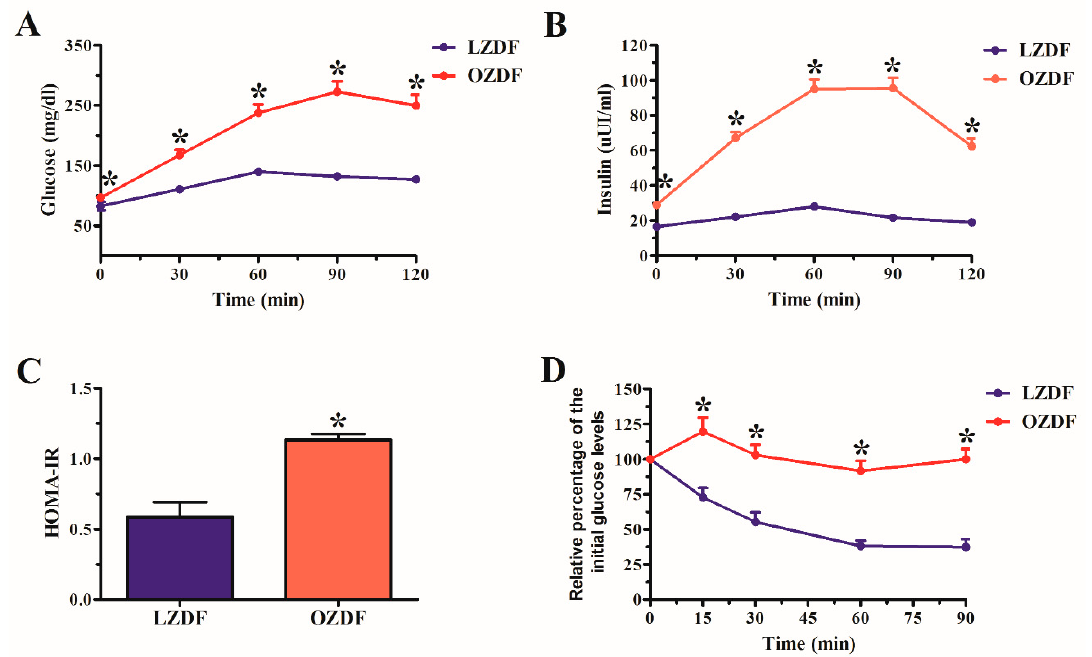
Figure 1. ( A ) Oral glucose tolerance test (OGTT). ( B ) Insulin concentration. ( C ) Homeostasis model assessment insulin resistance (HOMA-IR). ( D ) Insulin tolerance test (ITT). The values represent the